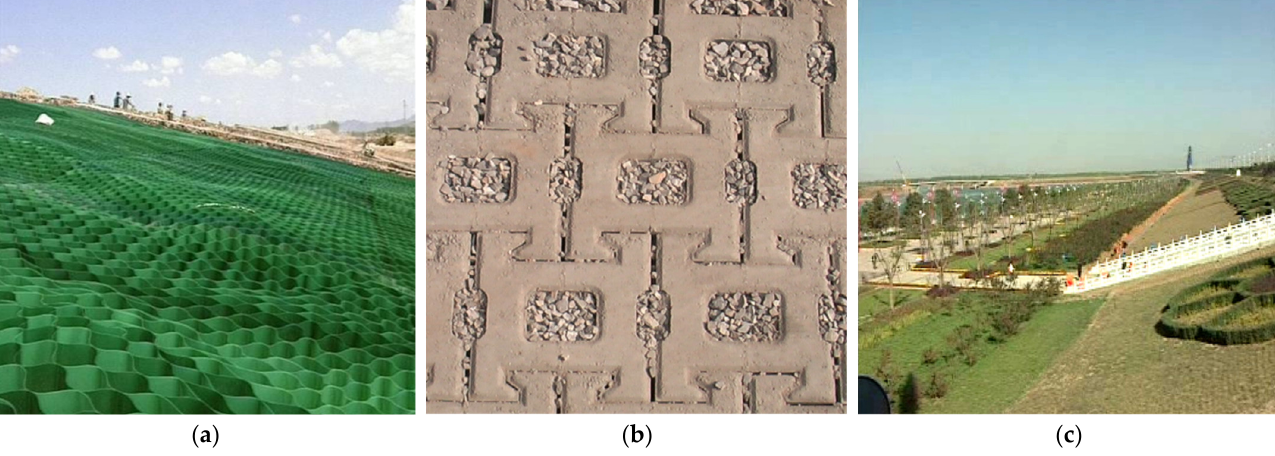
Figure 12. Ecological protection slope with different materials. ( a ) Gabion mesh in the building. ( b ) Interlocking concrete blocks. ( c ) Ecological protection slope of the dike.